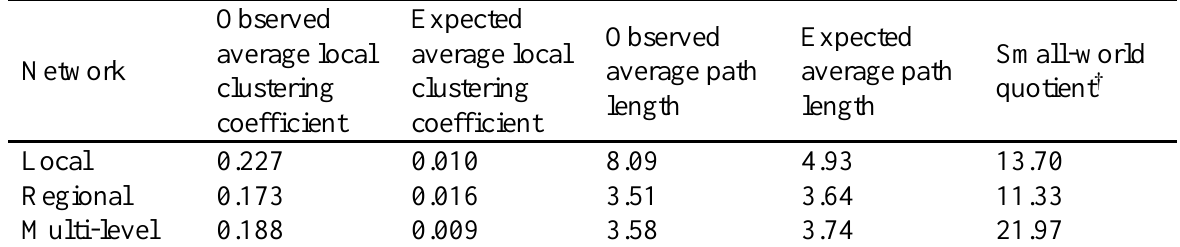
Table A2.1: Calculating the small-world quotient for local, regional, and multi-level networks Network